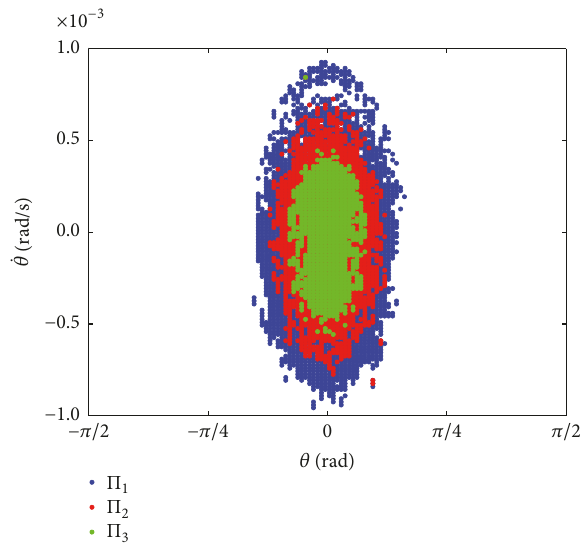
Figure 13: Comparison of parameter domains based on different specified regions.